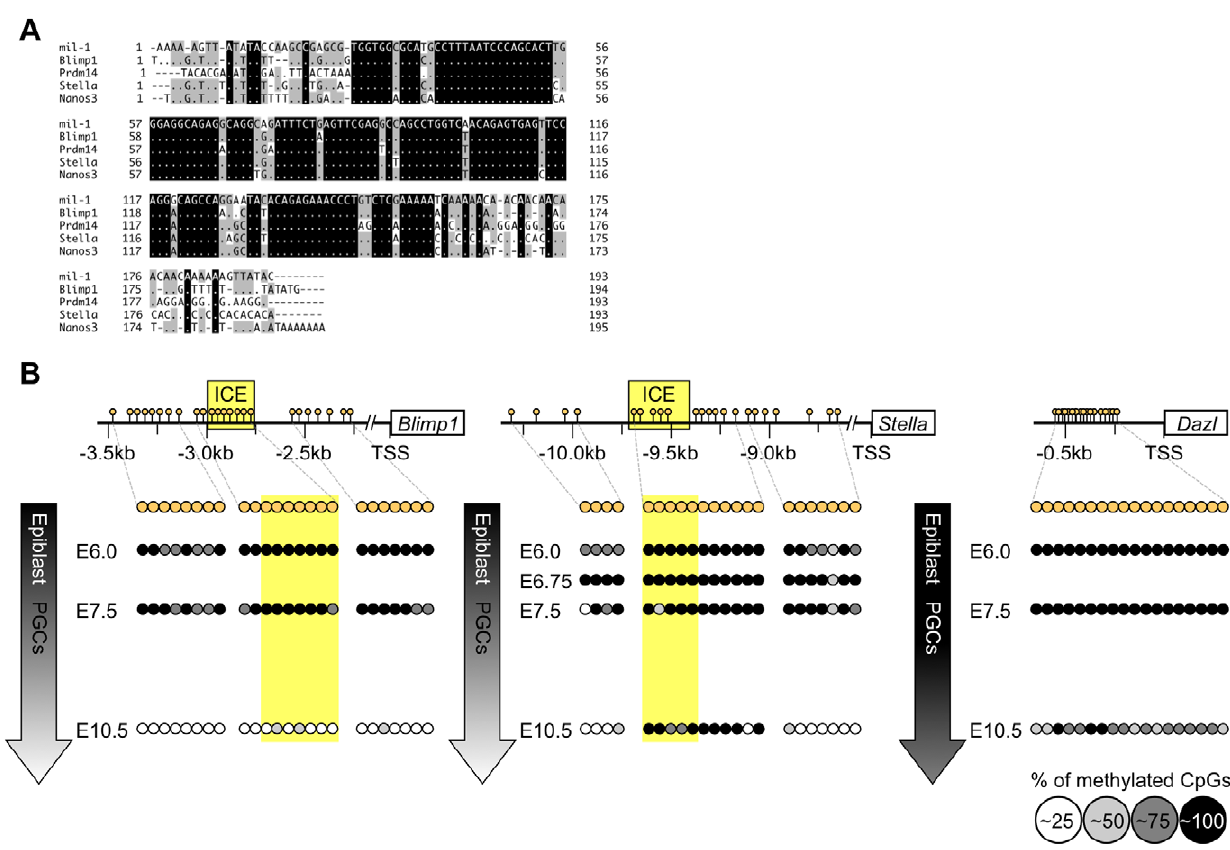
Figure 4. Flanking regions of the PGC-specific genes also become hypomethylated during PGC development. (A) Comparison of the Ifitm genes consensus element (ICE) of mil-1 / Ifitm3 [25] with the homologous sequences found in the putative regulatory regions flanking Blimp1 / Prdm1 , Prdm14 , Stella / Dppa3 , and Nanos3 . (B) Bisulfite sequencing analysis of the flanking regions of Blimp1 , Stella , and Dazl was performed using epiblasts (E6.0 and E6.75) and PGCs (E7.5 and E10.5). The flanking regions of Blimp1 and Stella , like those in mil-1 , were also progressively demethylated during PGC development, whereas that of Dazl was maintained hypermethylated in PGCs at E10.5.